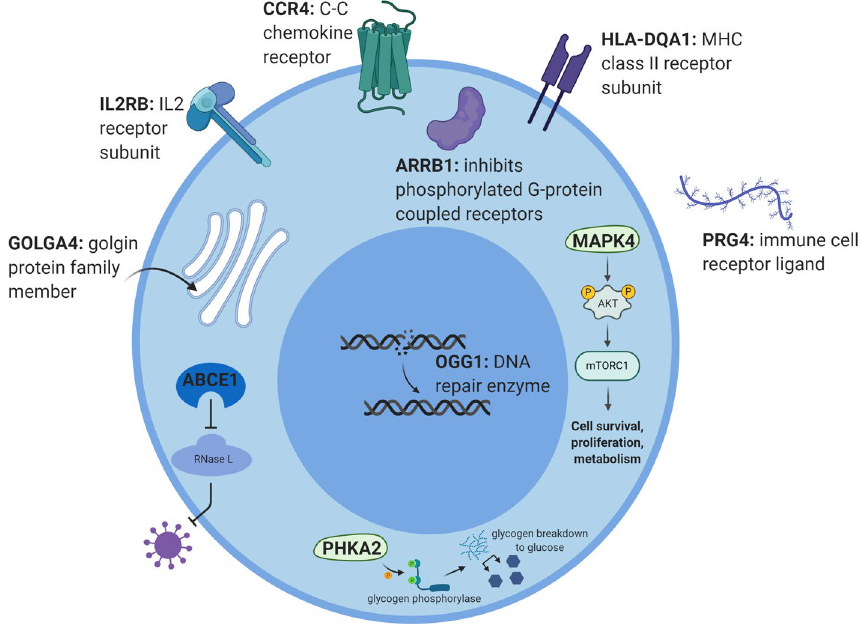
Figure 4. Visualization of the functions and locations of ten proteins in a hypothetical immune cell setting. All ten mRNA transcripts were downregulated in PBMCs of ME/CFS patients compared to healthy controls. Created with